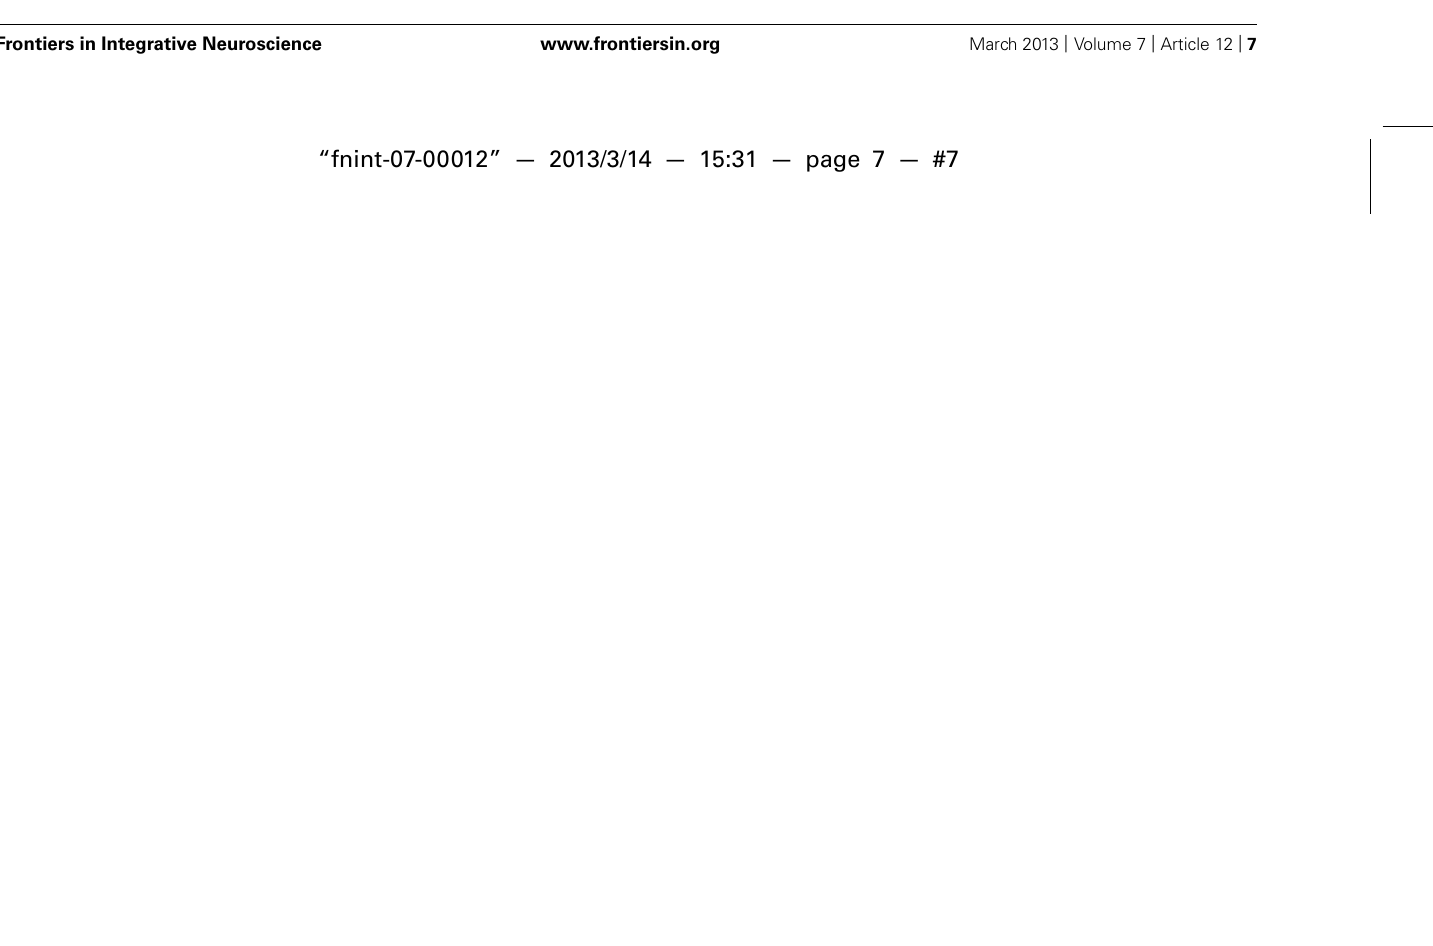
significantly longer exploration of the new (white column) as compared to the old (gray column) object at any time-point ( n = 10 in first week, n = 10 in second week, n = 9 in third week, n = 9 in fourth week). (F) A single MK801-injection leads to a long-term impairment in object recognition memory performance which lasts for at least 3 weeks after treatment. 1 ( n = 11), 2 ( n = 13) or 3 weeks ( n = 12) after an acute MK801-induced psychosis-related event, rats are not able to distinguish the familiar (gray column) from the new (white column) object, as indicated by approximately equal exploration times. In the 4 week ( n = 13) after MK801-treatment memory performance is significant but still tends to be poorer than the performance seen in controls.Values represent means ± S.E.M.; * p < 0.05, ** p < 0.001, *** p <